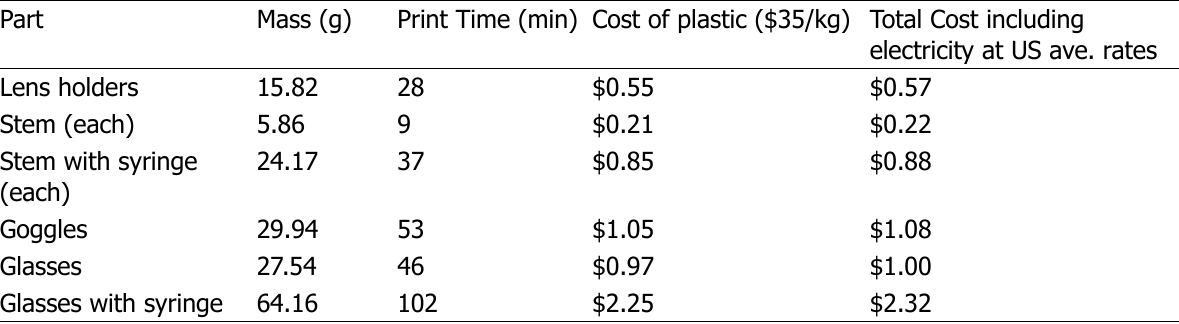
Figure 7. Screenshot of thingiverse customizer application used for customizing the 3D printable self- adjusting lenses glasses for a) the front of the glasses and b) the stems. Table 1. Mass, print time, polymer costs, and total cost of 3-D printable designs using commercial fila- ment and standard printing procedures